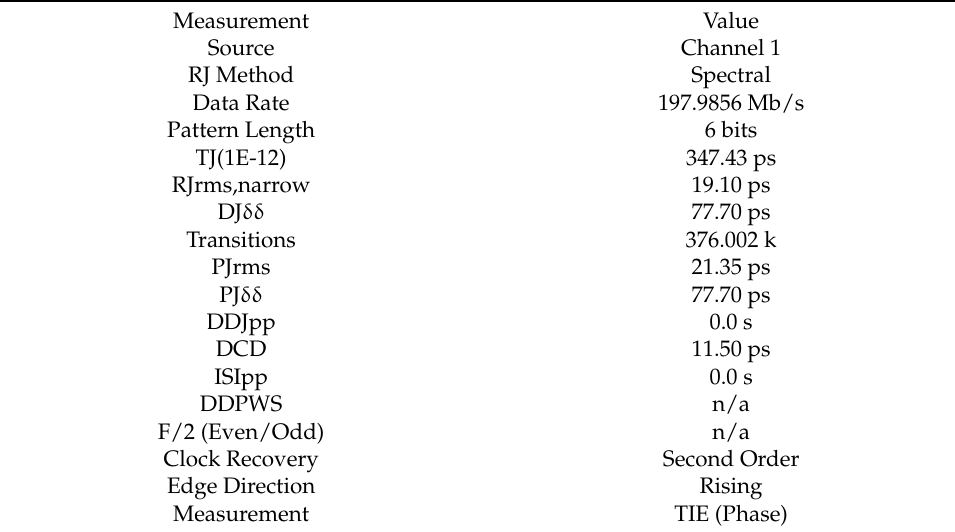
Table 4. Summary of Jitter